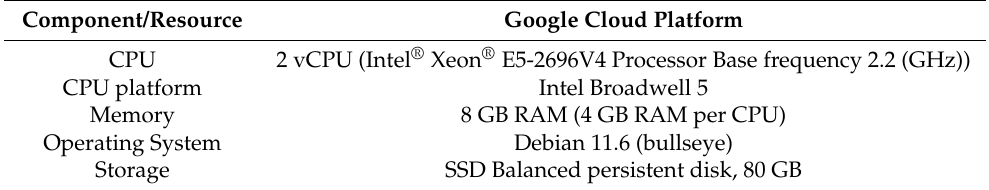
Table 1. Properties of the worker, chosen from the Google Cloud